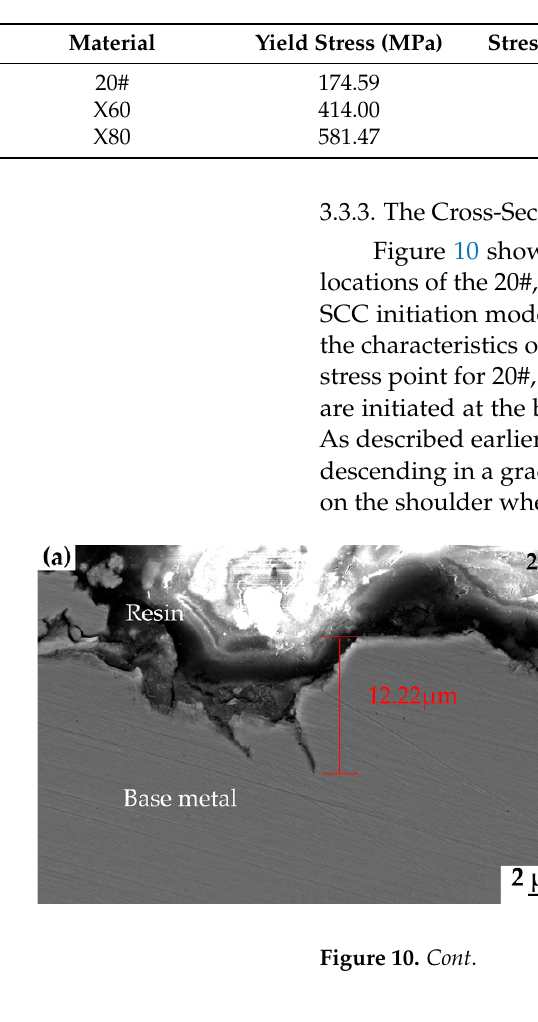
Figure 9. Determination of threshold stress for crack initiation ( a ) 20#, ( b ) X60, and ( c ) X80. Table 3. Threshold stress for SCC initiation of 20#, X60, and X80 steels.